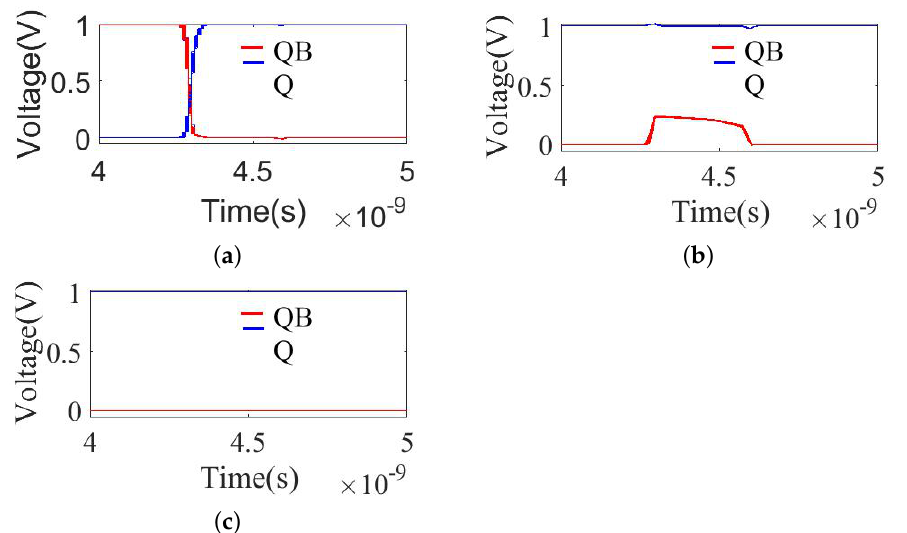
Figure 12. Simulated RSWA12T SRAM cell for write operation: ( a ) selected cell; ( b ) column half- selected cell; ( c ) row half-selected cell, for 5000 samples’ Monte Carlo simulation.